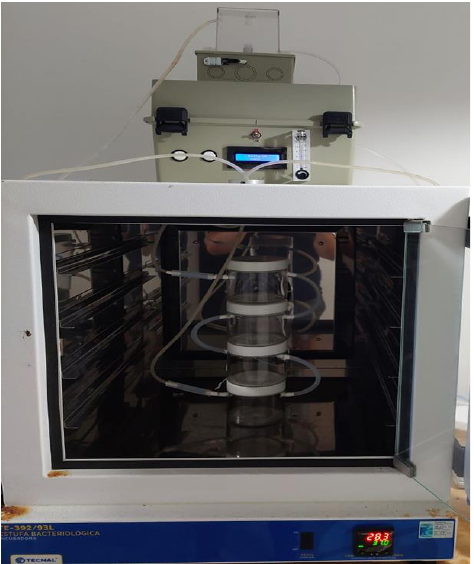
Figure 1. Cascade system used to perform biomineralization in cement.